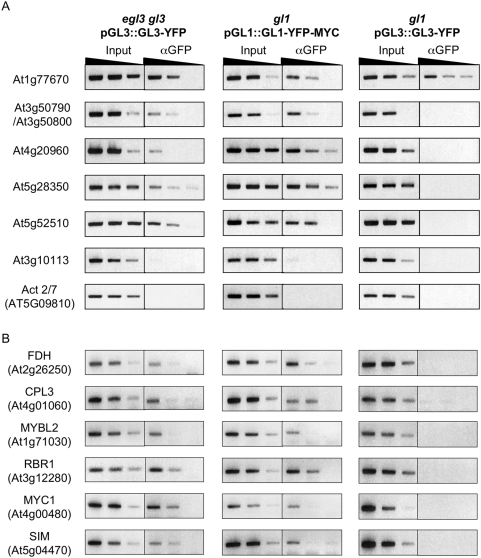
Validation of GL1 and GL3 direct target genes.(A) Semi-quantitative PCR of ChIP experiments performed on gl3 egl3 pGL3::GL3-YFP, gl1 pGL1::GL1-YFP-MYC or gl1 pGL3::GL3-YFP plants of genes selected by ChIP-chip. Serial 4-fold dilutions used for PCR are represented by the black triangles. PCR were performed on regions 500 bp upstream from the TSS, except for Act 2/7, for which PCR was performed on the 5′UTR. (B) Semi-quantitative PCR of ChIP experiments performed on gl3 egl3 pGL3::GL3-YFP, gl1 pGL1::GL1-YFP-MYC or gl1 pGL3::GL3-YFP plants of trichome genes (Table S1) identified as GL3 and GL1 targets (Figure S5). Serial 4-fold dilutions used by PCR are represented by the black triangles. PCR were performed on regions 500 bp upstream from the TSS, except for Act 2/7, for which PCR was performed on the 5′UTR.